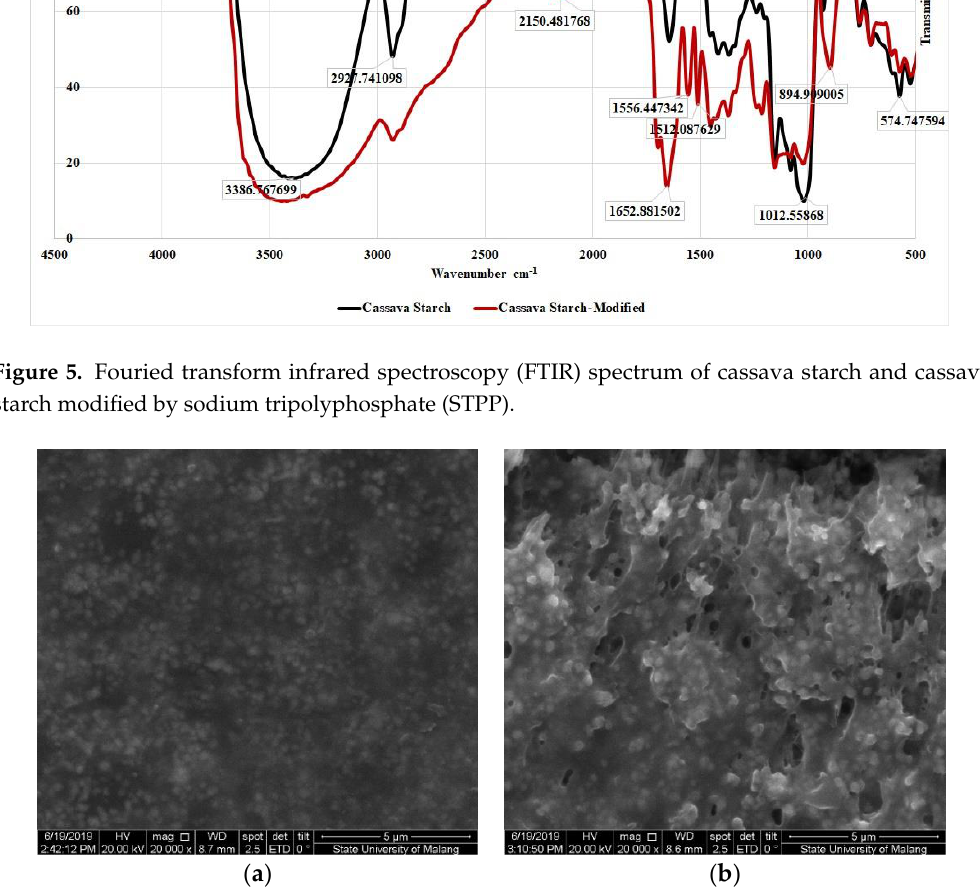
Figure 5. Fouried transform infrared spectroscopy (FTIR) spectrum of cassava starch and cassava starch modified by sodium tripolyphosphate (STPP).